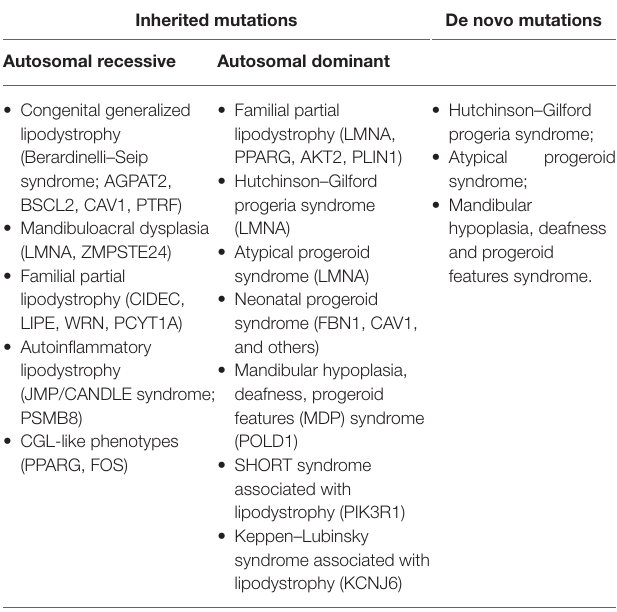
TABLE 1 | Genetic lipodystrophies listed according to their possible inheritance patterns. Inherited mutations De novo mutations Autosomal recessive Autosomal